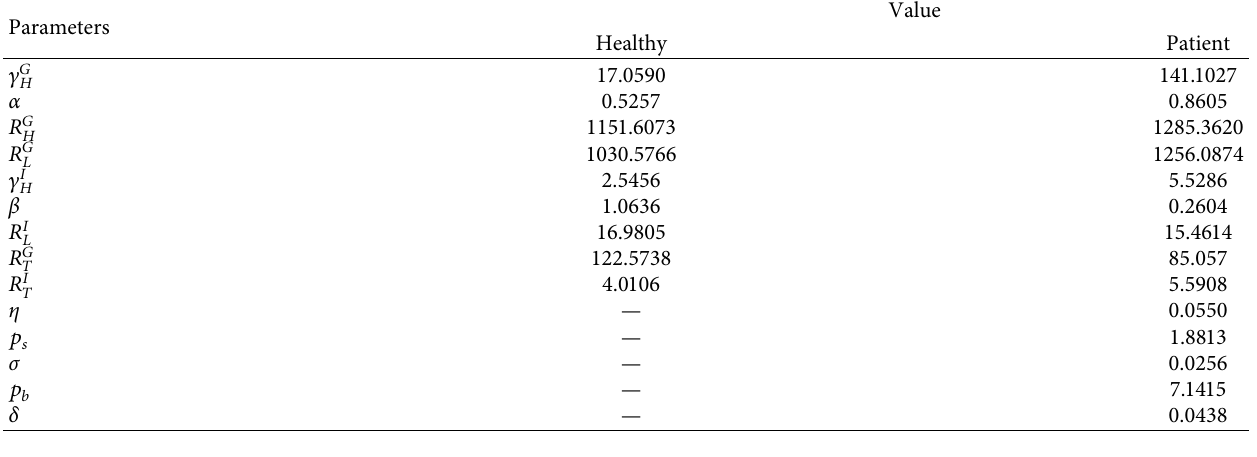
Table 4: Estimated model parameters.